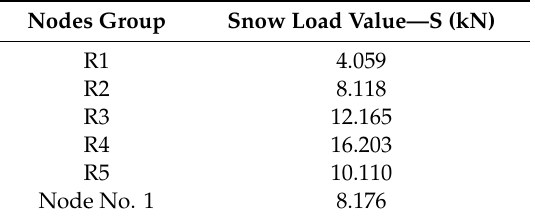
Table 5. Dome loaded with uniform snow load represented as concentrated forces.